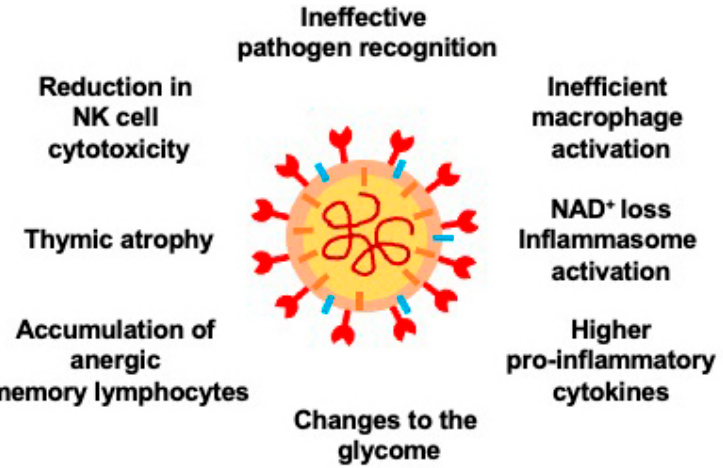
Figure 1. Schematic diagram of how age-related alterations escalate susceptibility of COVID-19. The aging immune system are subject to innate and adaptive immunosenescence, and inflammaging. An age-associated decrease in NAD + leads to de-repression of NLRP3 and activation of inflammasome in older people, further aggravating the cytokine storm. The glycome regulating a variety of immune signaling pathways changes during aging.